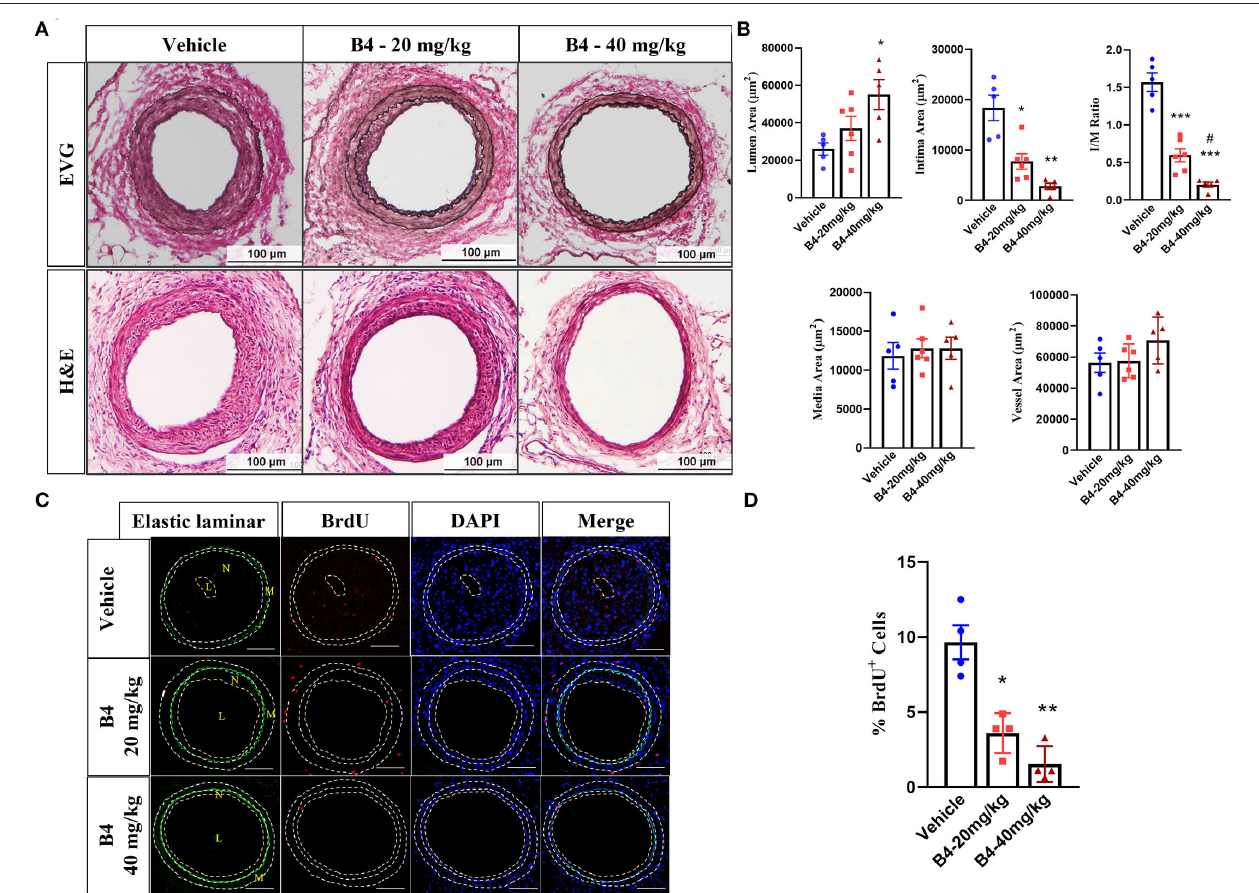
FIGURE 1 | B4 attenuates neointima formation in a murine femoral artery wire injury model. Six-week-old C57BL/6J male mice were intraperitoneally injected with B4 (20 mg/kg/d), (40 mg/kg/d), or saline (Vehicle) daily for 3 weeks. (A) Elastic van Gieson (EVG, upper panel) and H&E staining (lower panel) staining of injured femoral arteries (Vehicle) and B4 (20 mg/kg/d), (40 mg/kg/d). Scale bar, 100 µ m. (B) Morphometric analysis of lumen area, neointima area, intima-to-media ratio, media area, and vessel area of injured femoral arteries from mice injected with vehicle or B4. (C) Representative BrdU immunofluorescence stained images of the sections from vehicle or B4. The dotted line represents the auto-fluorescent of elastic laminar. Scale bar, 100 µ m. (D) The percentage of BrdU positive cell number was quantified in sections from sham-operated and injured femoral arteries from vehicle or B4 treated mice. Cells in the media and neointima layers (between the external elastic laminar and the lumen of each section) were included. Data shown are means ± SEM. N = 5 for control and N = 6 for B4 treatment. * P < 0.05; ** P < 0.01; *** P < 0.001; compared with Vehicle group. # P < 0.05; compared with B4-20mg/kg group.